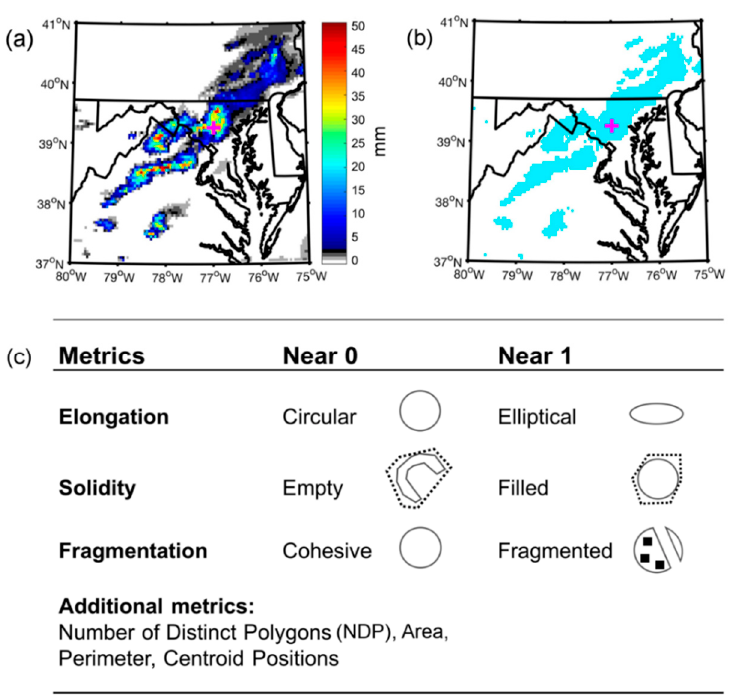
Figure 3. Demonstration of methodology for calculating object-based metrics based on ( a ) the full precipitation field, ( b ) the binary image corresponding to precipitation greater than 2.54 mm, and ( c ) spatial metrics included in